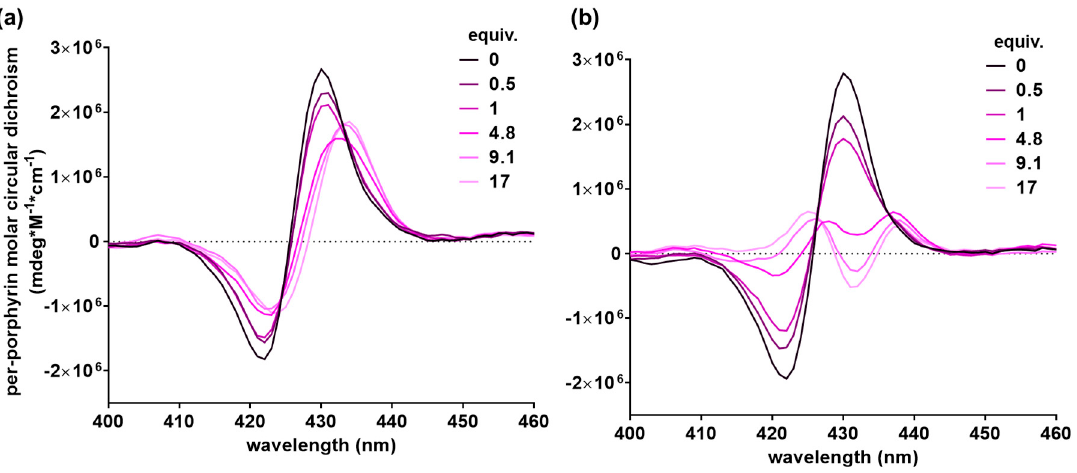
Figure 6. CD and UV-vis spectral change of 2 ( 1 μ M in CH 2 Cl 2 , 20 °C) with ( a ) D -Lys-OMe and ( b ) L -Lys-OMe.